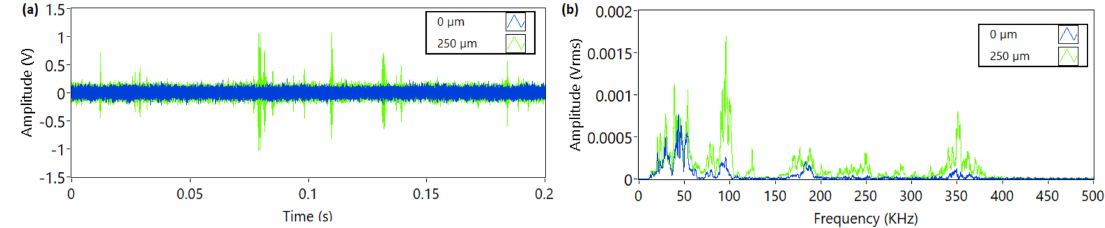
Figure 8. ( a ) Time-domain and ( b ) frequency-domain signals captured from tool with V b = 0 µ m and V b = 250 µ m.